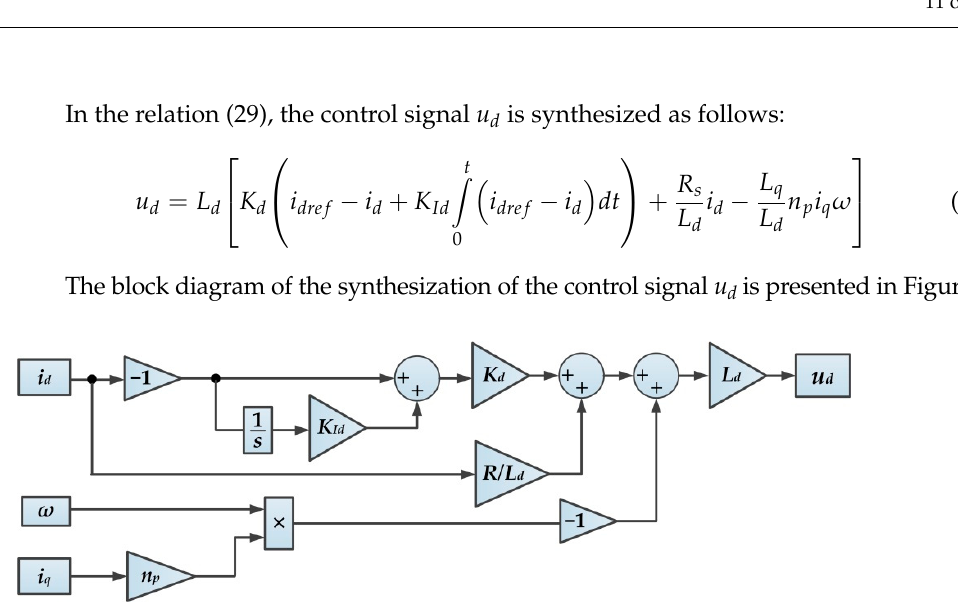
Figure 8. Block diagram of the synthesized control signal u d .